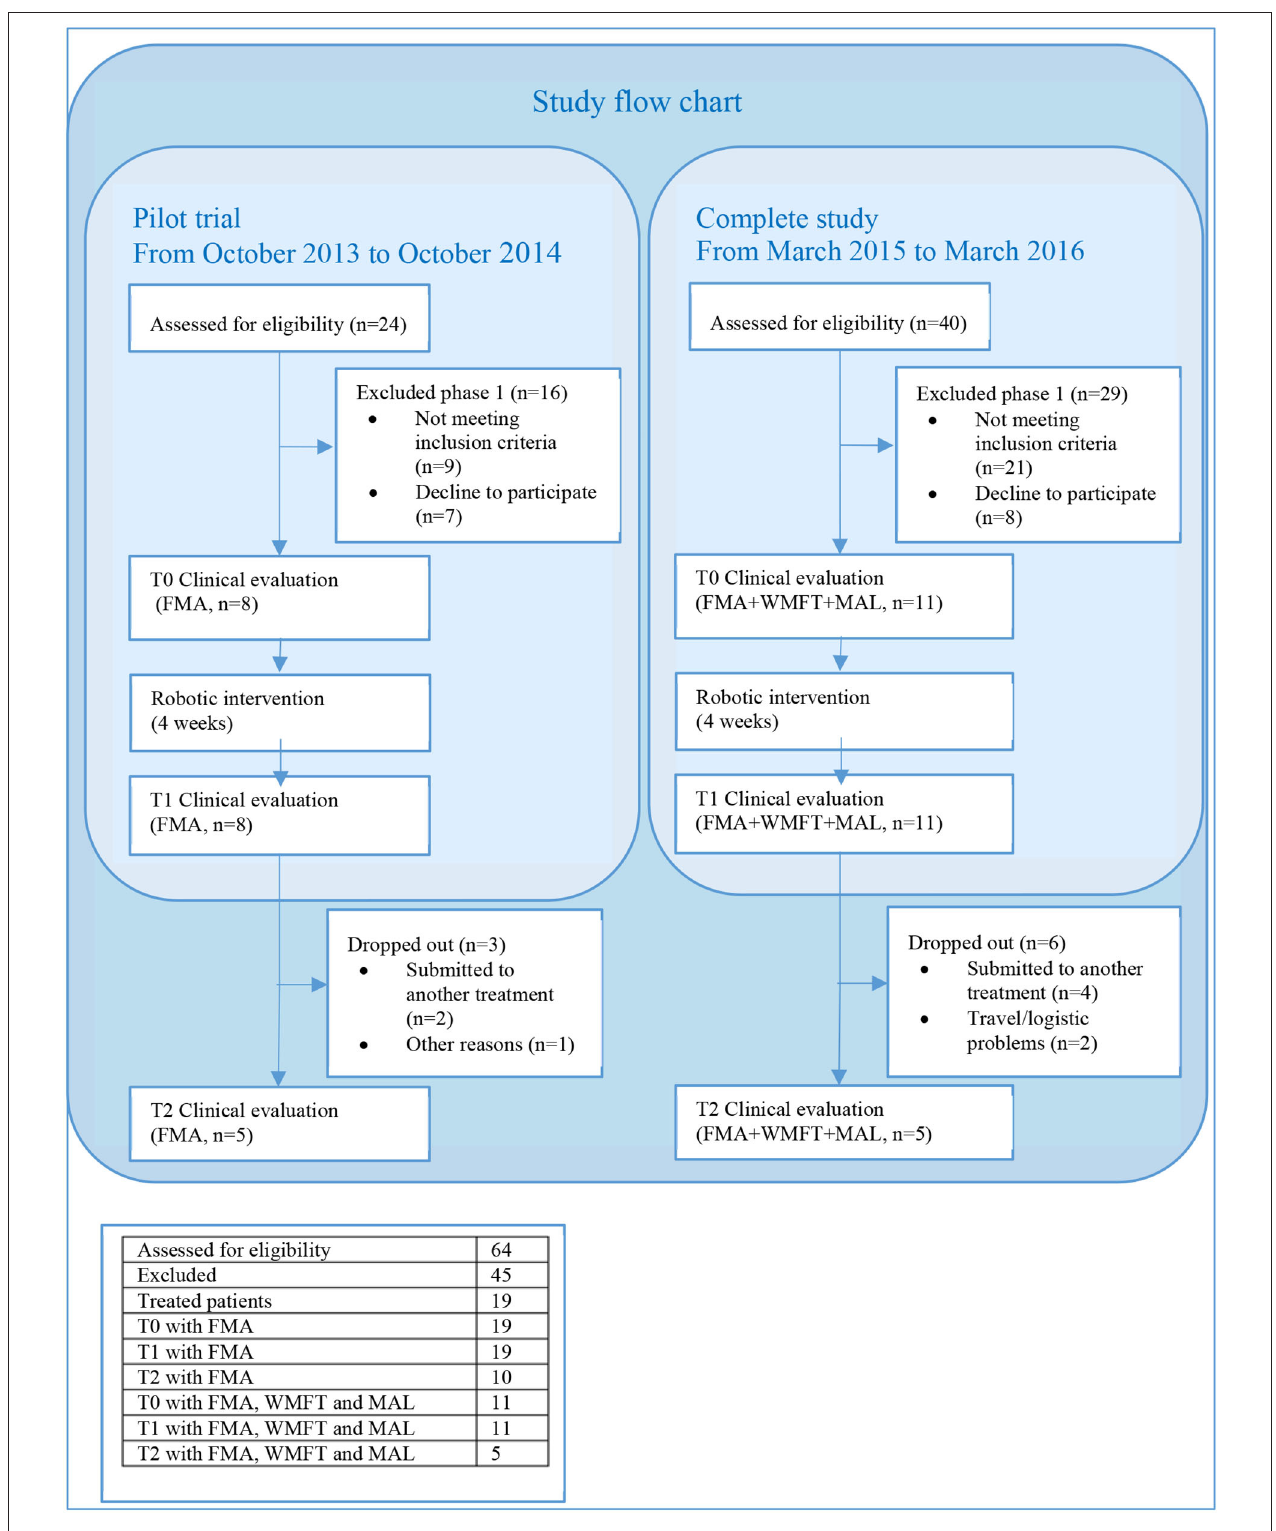
FIGURE 1 | Study flow chart. The pilot trial took place from October 2013 to October 2014. Twenty-four patients selected from the Villa Beretta database were called over the phone and invited to participate in the study. Seventeen agreed and were screened; 5 were excluded, mainly because they were not able to hold the robot handle during one of the two movements, and 7 refused to participate. From March 2015 to March 2016, a total of 40 patients with chronic stroke who were referred to the outpatient clinic of Villa Beretta were screened; 23 were excluded because of not meeting the inclusion criteria (insufficient shoulder and elbow active ROM or inability to hold the robot handle), and 6 refused to participate. The most common reason for refusing to participate referred to difficulties in reaching the facility.